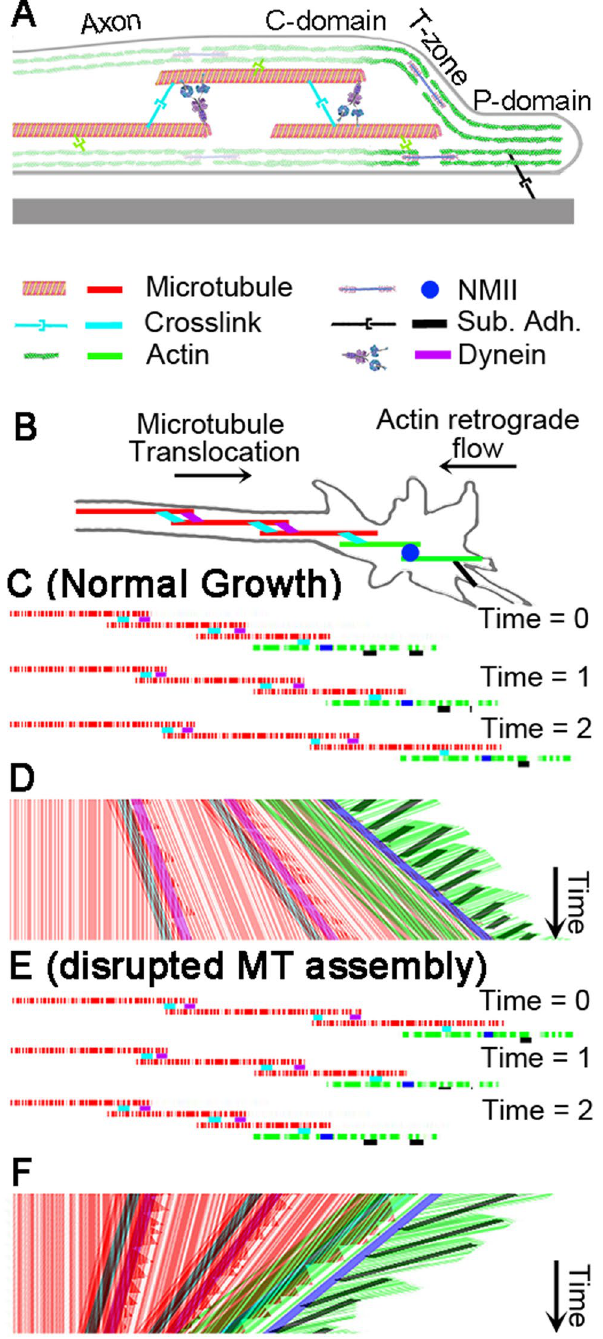
Figure 5. Model of neurite elongation by bulk forward translocation of MTs. ( A ) Side view of growth cone and distal neurite with important cytoskeletal elements. ( B ) Schematic of a growth cone and distal neurite with important cytoskeletal components and substrate adhesion (black). ( C ) Three MTs (red) and two actin filaments (green) labeled with fluorescent speckles at different time points. ( D ) Hypothetical kymograph of MTs (red), F-actin (green), motors (purple and blue), and cross linking proteins (light blue). Anterograde red lines reveal forward movement of MTs in the distal neurite and C-domain and retrograde green lines reveal retrograde movement of F-actin in P domain. ( E ) Illustration of MT and F-actin configuration under conditions where disruption of MT assembly induces retraction of the growth cone. ( F ) A hypothetical kymograph of MT and F-actin motion. While axonal frictional interactions with the substrate, as well as axonal actin and myosin activity are all important for both elongation and retraction, they are not shown to minimize the complexity of the